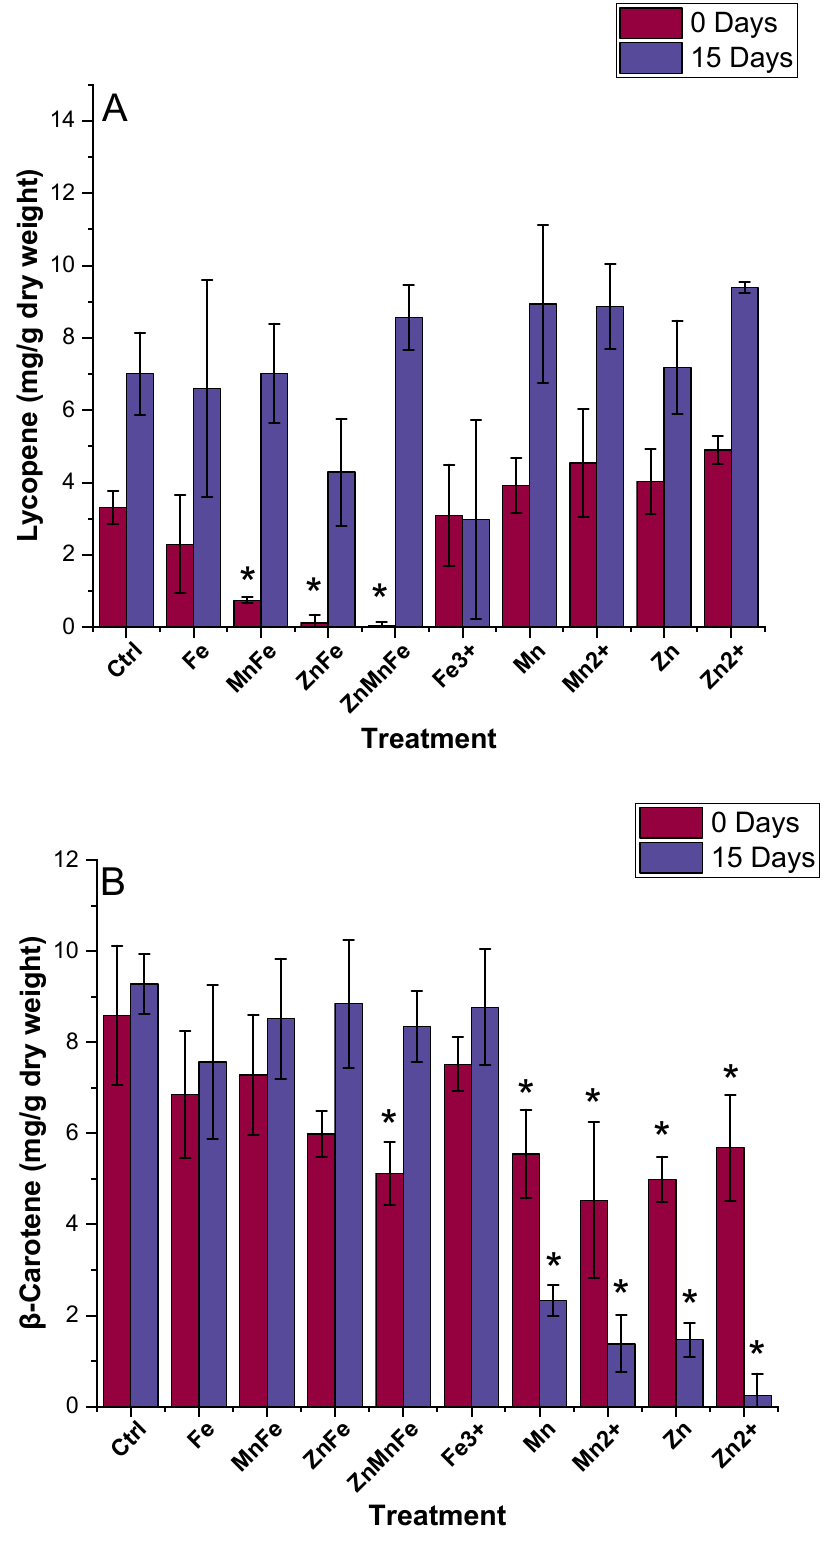
Figure 7. Effects of Fe 3 O 4 (Fe), MnFe 2 O 4 (MnFe), ZnFe 2 O 4 (ZnFe), Zn 0.5 Mn 0.5 Fe 2 O 4 (ZnMnFe), Mn 3 O 4 (Mn), ZnO (Zn), and their ionic counterparts on the ( A ) lycopene and ( B ) β -carotene concentrations at 0 and 15 stored days; n = 4; * denotes statistical difference between control and treatments.